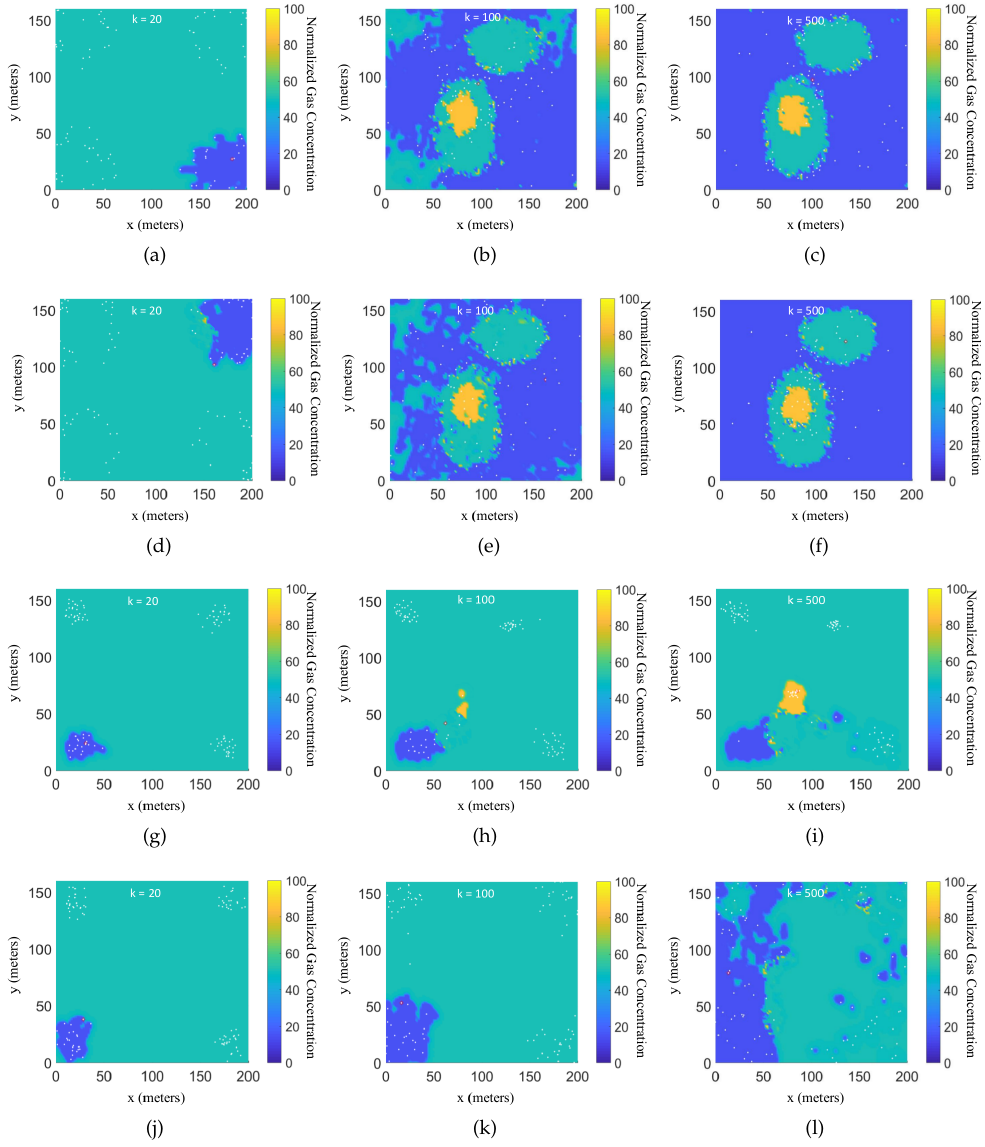
Figure 3. Evolution of the estimated gas distribution map in the indoor environment generated by the n ∗ th robot in each simulation at three instants in time, where the red point indicates the position of the n ∗ th robot and white points indicate the other robots, where the sub-figures in the first row ( a – c ) show the evolution of the estimated gas distribution obtained by the EAPF algorithm; the sub-figures in the second row ( d – f ) show the evolution of the estimated gas distribution obtained by the EPSO algorithm; the sub-figures in the third row ( g – i ) show the evolution of the estimated gas distribution obtained by the CPSO algorithm; and the sub-figures in the fourth row ( j–l ) show the evolution of the estimated gas distribution obtained by the RW